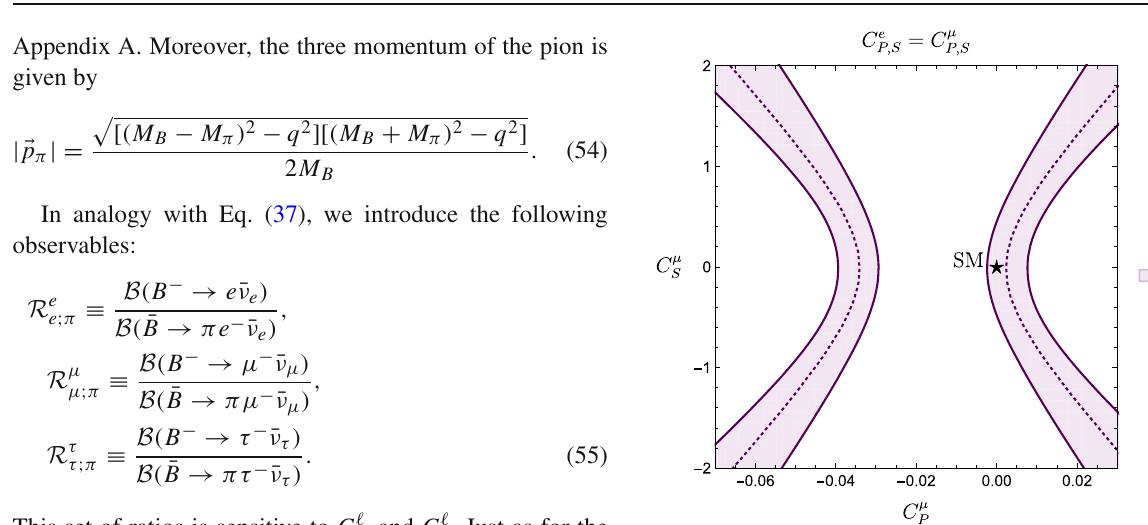
Fig. 8 Constraintsinthe C semileptonic ratio R